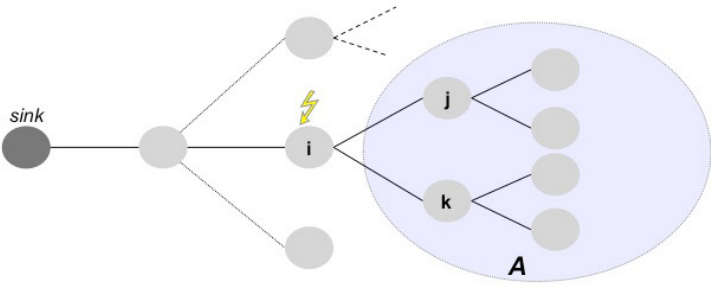
Figure 2. Isolation of a Wireless Sensor Network